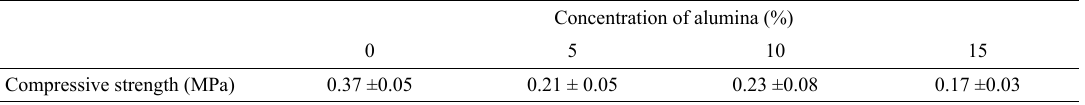
O scaffolds. 2 3